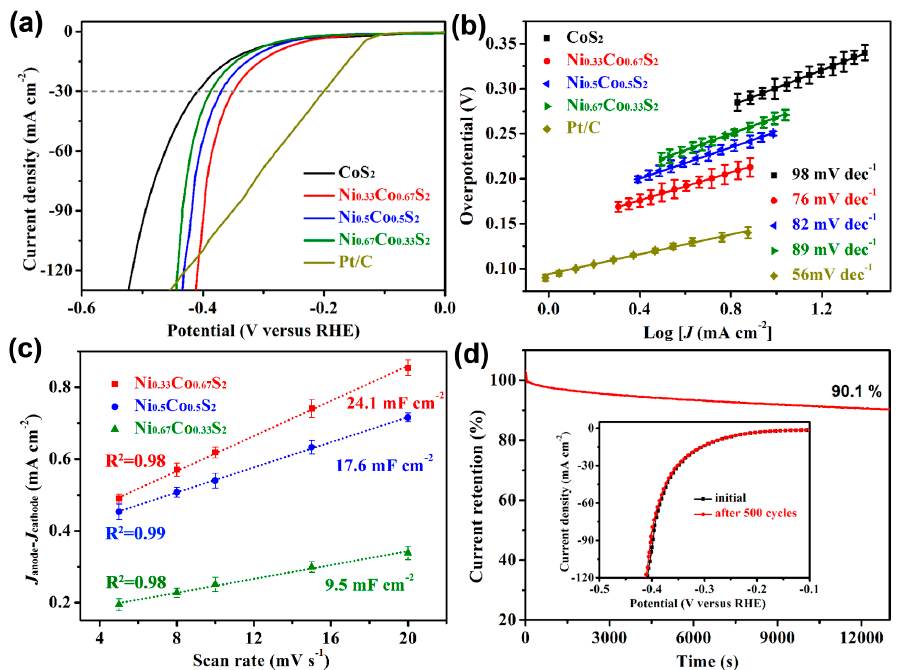
Figure 6. ( a ) HER polarization curves of commercial Pt/C, bare CoS 2 and Ni-doped CoS 2 on SS in 1.0 M KOH. The scan rate is 5 mV s − 1 ; ( b ) Fitted Tafel slopes; ( c ) Calculation of double-layer capacitance by fitting the capacitive current vs. scan rates. The error bar stands for the results, ranging from three independent repeated measurements; ( d ) Chronoamperometric data of Ni 0.33 Co 0.67 S 2 NN/SS at